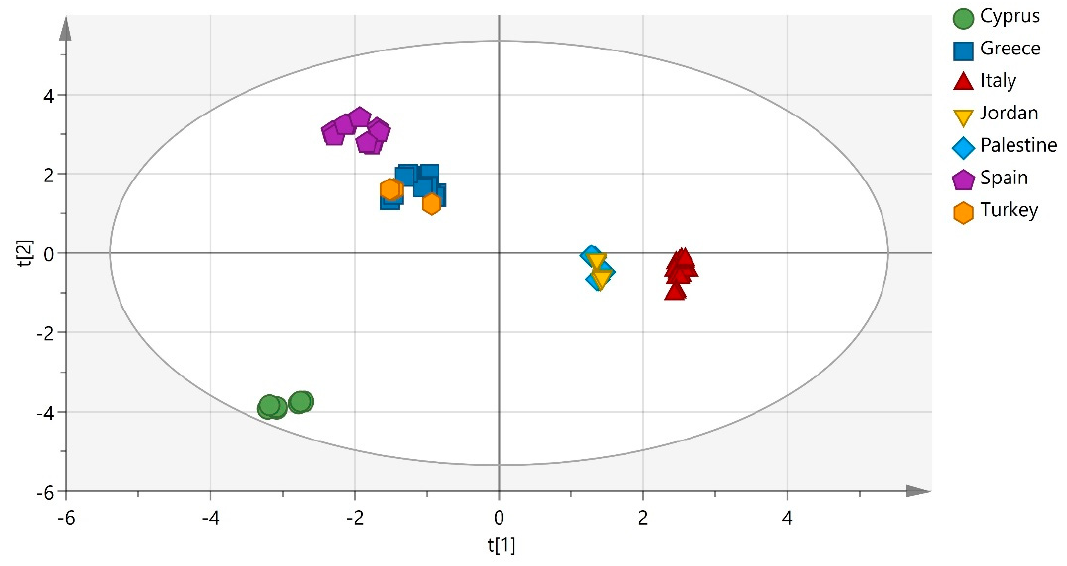
Figure 2. Partial least square-discriminant analysis model, according to origin (R 2 X (cum) = 0.70, Q 2 (cum) = 0.91), discriminating Cypriot carobs from Italy and Spain.